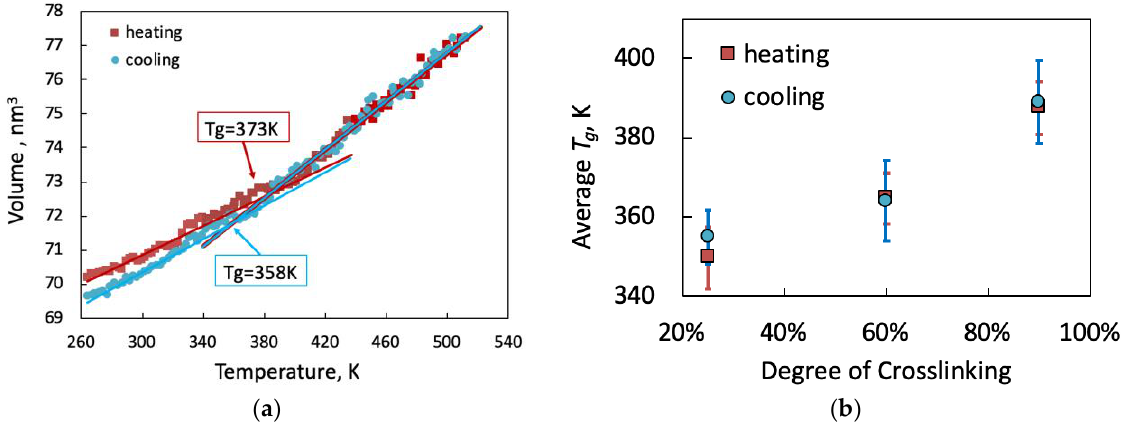
Figure 8. ( a ) Volume change during temperature increment and decrement around glass transition at 90% degree crosslinking and ( b ) average glass transition temperature as a function of degree of crosslinking evaluated during heating and cooling simulations.